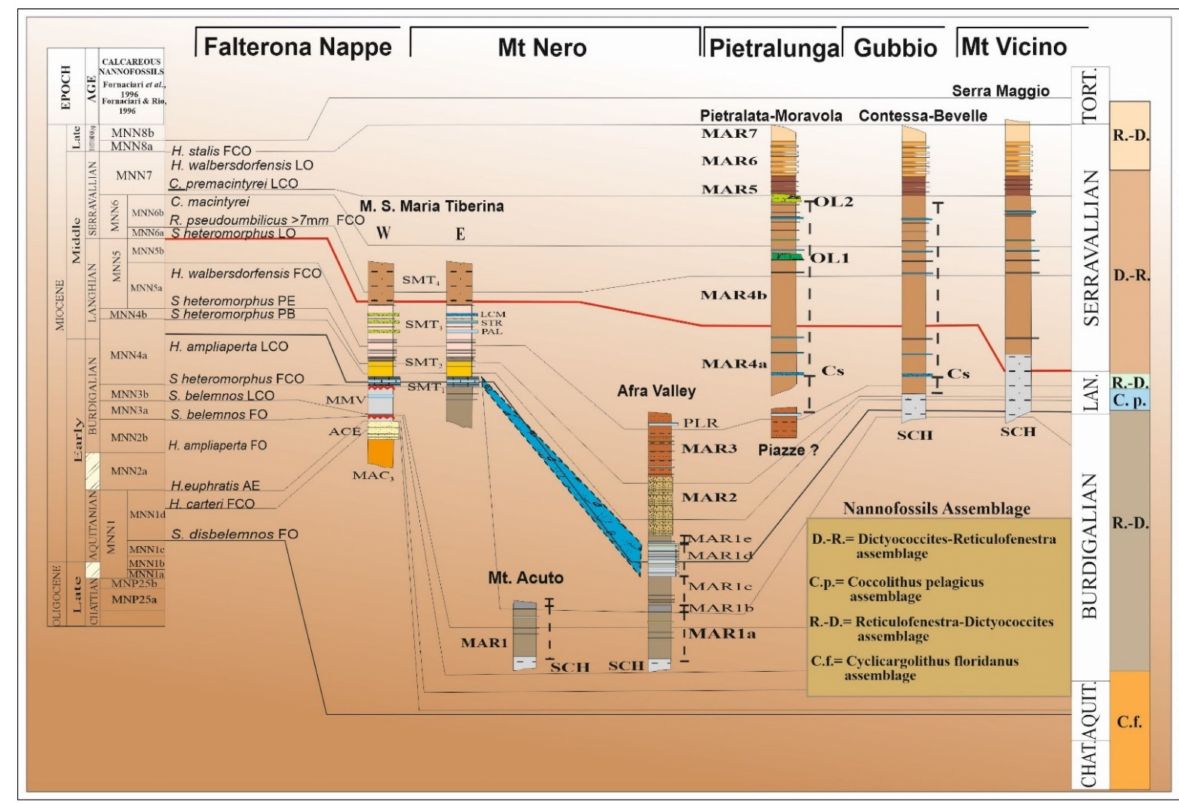
Figure 3. Comprehensive stratigraphic scheme of the Umbria pre-Apennine Marnoso Arenacea succession cropping out East of the Falterona Nappe and Mt Rentella frontal thrusts to the inner side of the carbonate chain. The columns represent, to all effects, composite Logs obtained by correlating the studied sections, located in Figure